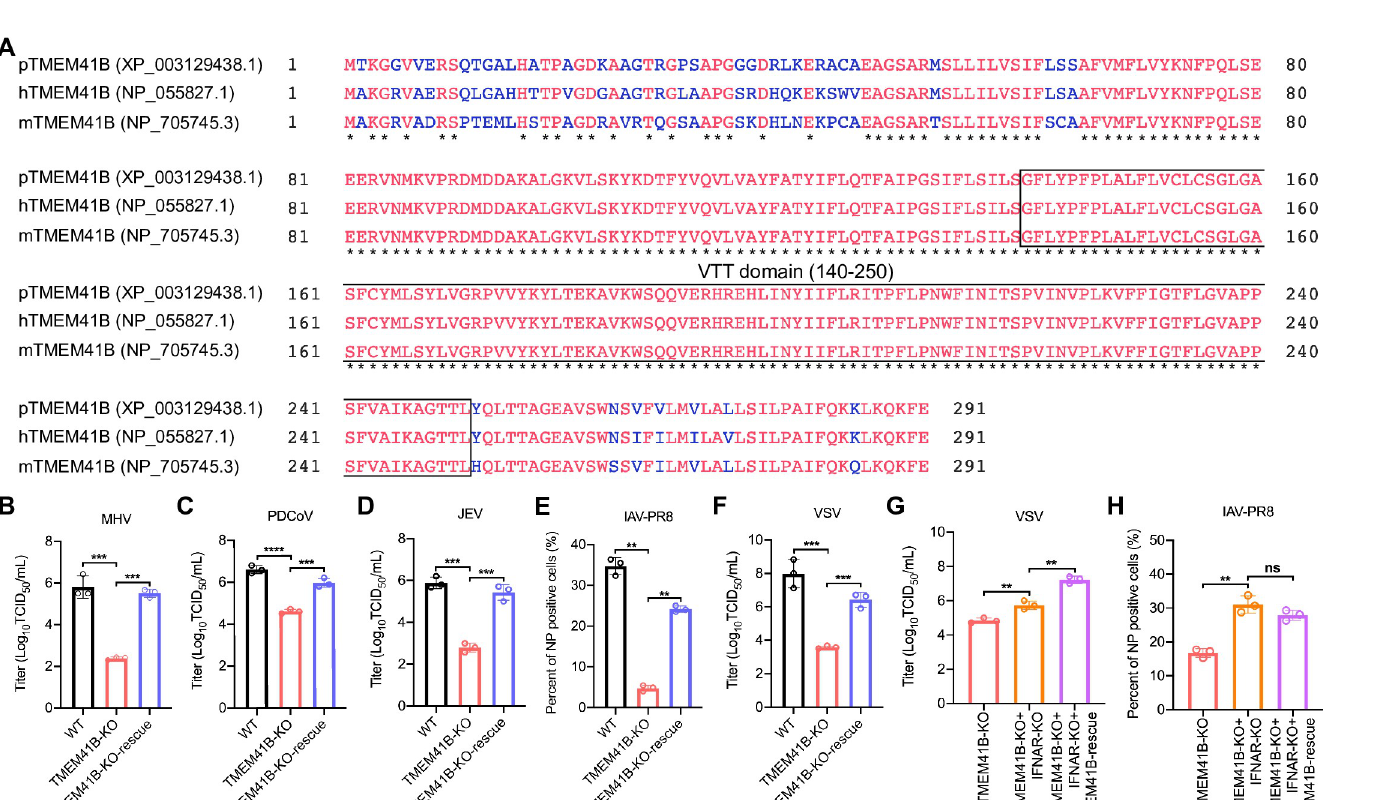
Fig 5. TMEM41B contributes to the formation of CoVs replication organelles. (A-D) Representative images from transmission electron microscope of TGEV (MOI = 0.1, 24 h) induces membrane structures. There are typical DMVs (diameter ~200 nm) were observed ( A and B ). Electron micrograph of an area with abundant double-membrane spherule (DMSs) ( C ) and irregular coiled membrane formed by ERs expansion ( D ). Scale bar, 1 μ m or 500 nm. (E-F) Electron micrograph showing mock-infected and TGEV-infected (MOI = 0.1, 24 h) TMEM41B KO cells bearing several monolayer vesicles. Scale bar, 500 nm or 250 nm. (G) Confocal fluorescence microscopy analysis of the co-localization of TGEV-NSP3-HA (indicated in red) and restored expression of TMEM41B-FLAG (indicated in fuchsia) in TMEM41B KO cells. Scale bar, 5 μ m. (H) Analysis of the subcellular location of ectopic expression TMEM41B in KO cells mock-infected (above) or infected with TGEV (MOI = 1, 12 h) (bottom). The restored expression of TMEM41B (indicated in red) were co-localization with dsRNA (indicated in green). Scale bar, 5 μ m. (I) Assessment of the co-localization of dsRNA (indicated in green) and ectopic expression of TMEM41B-FLAG (indicated in red) in L929 cells during MHV (MOI = 1, 12 h) infection via confocal fluorescence microscopy. Scale bar, 5 μ m. (J) A model for the role of TMEM41B in the formation of coronavirus replication organelles. WT, wild-type; KO, knock out; Mock, uninfected cells; TGEV, Transmissible gastroenteritis virus infected cells; MHV, Mouse hepatitis virus infected cells; M, Mitochondria; ER, Endoplasmic reticulum; DAPI, 4’,6-diamidino-2-phenylindole; HA, HA-Tag; FALG, 3 × FLAG-Tag; dsRNA, double-stranded RNA.